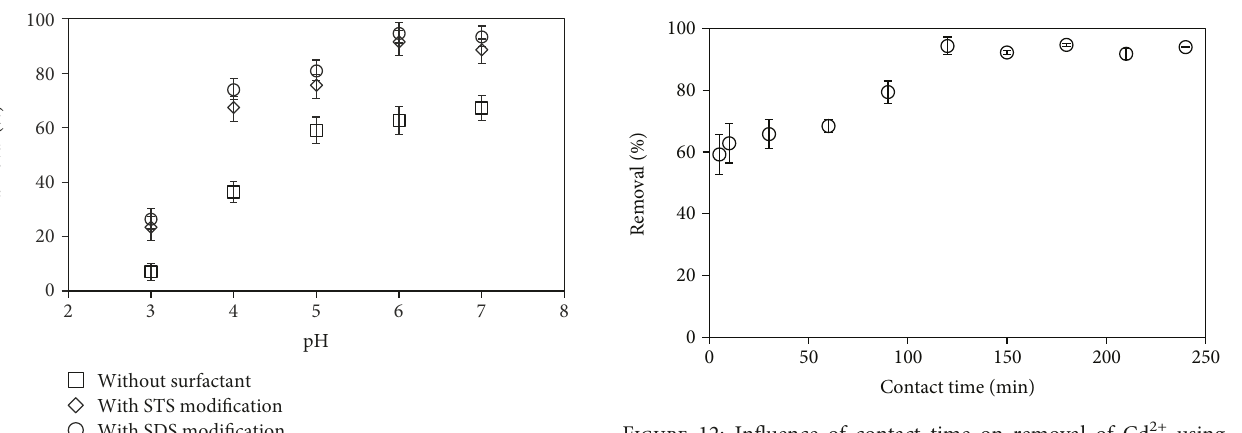
O after STS adsorption in the wavenumber range of 400 – 4000cm − 1 . 2 3